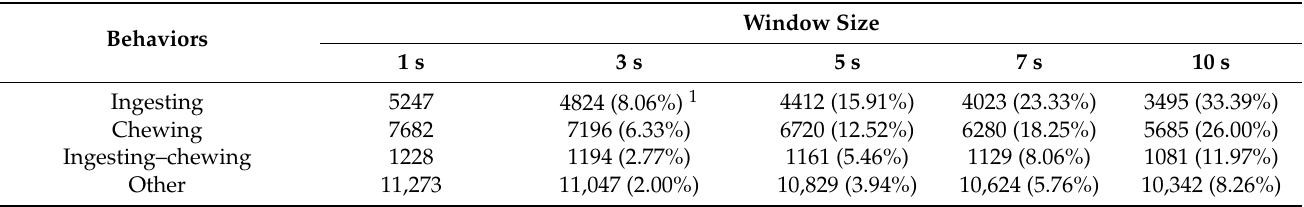
Table 4. Total number of sequences obtained for each behavior with different window sizes.